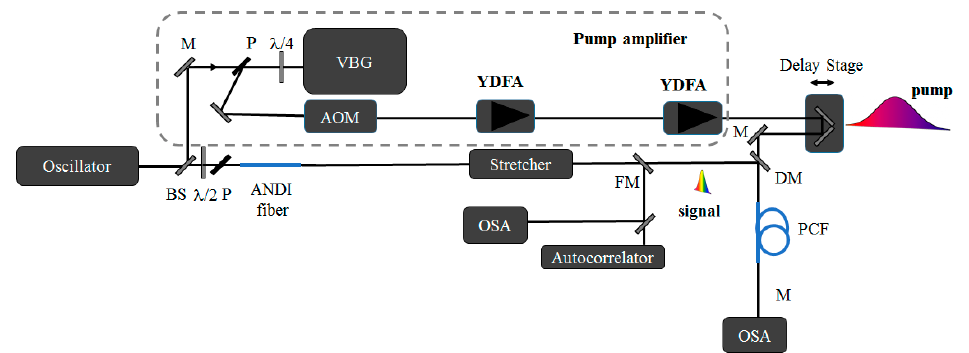
Figure 3. Experimental set-up. VBG, volume Bragg grating; AOM, acoustooptic modulator; YDFA, ytterbium doped fiber amplifier; OSA, optical spectrum analyzer; PCF, photonic crystal fiber; ANDI, all normal dispersion fiber; BS, beam splitter; M, mirror; P, polarizer; DM, dichroic mirror; FM, flipped mirror.